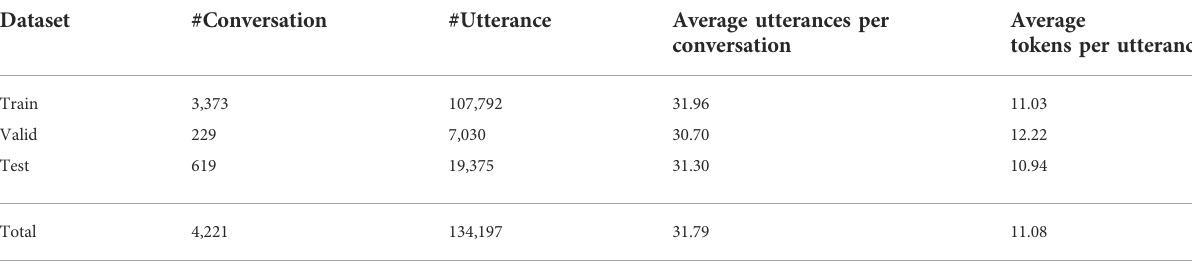
TABLE 2 Statistics of the CMU_DoG